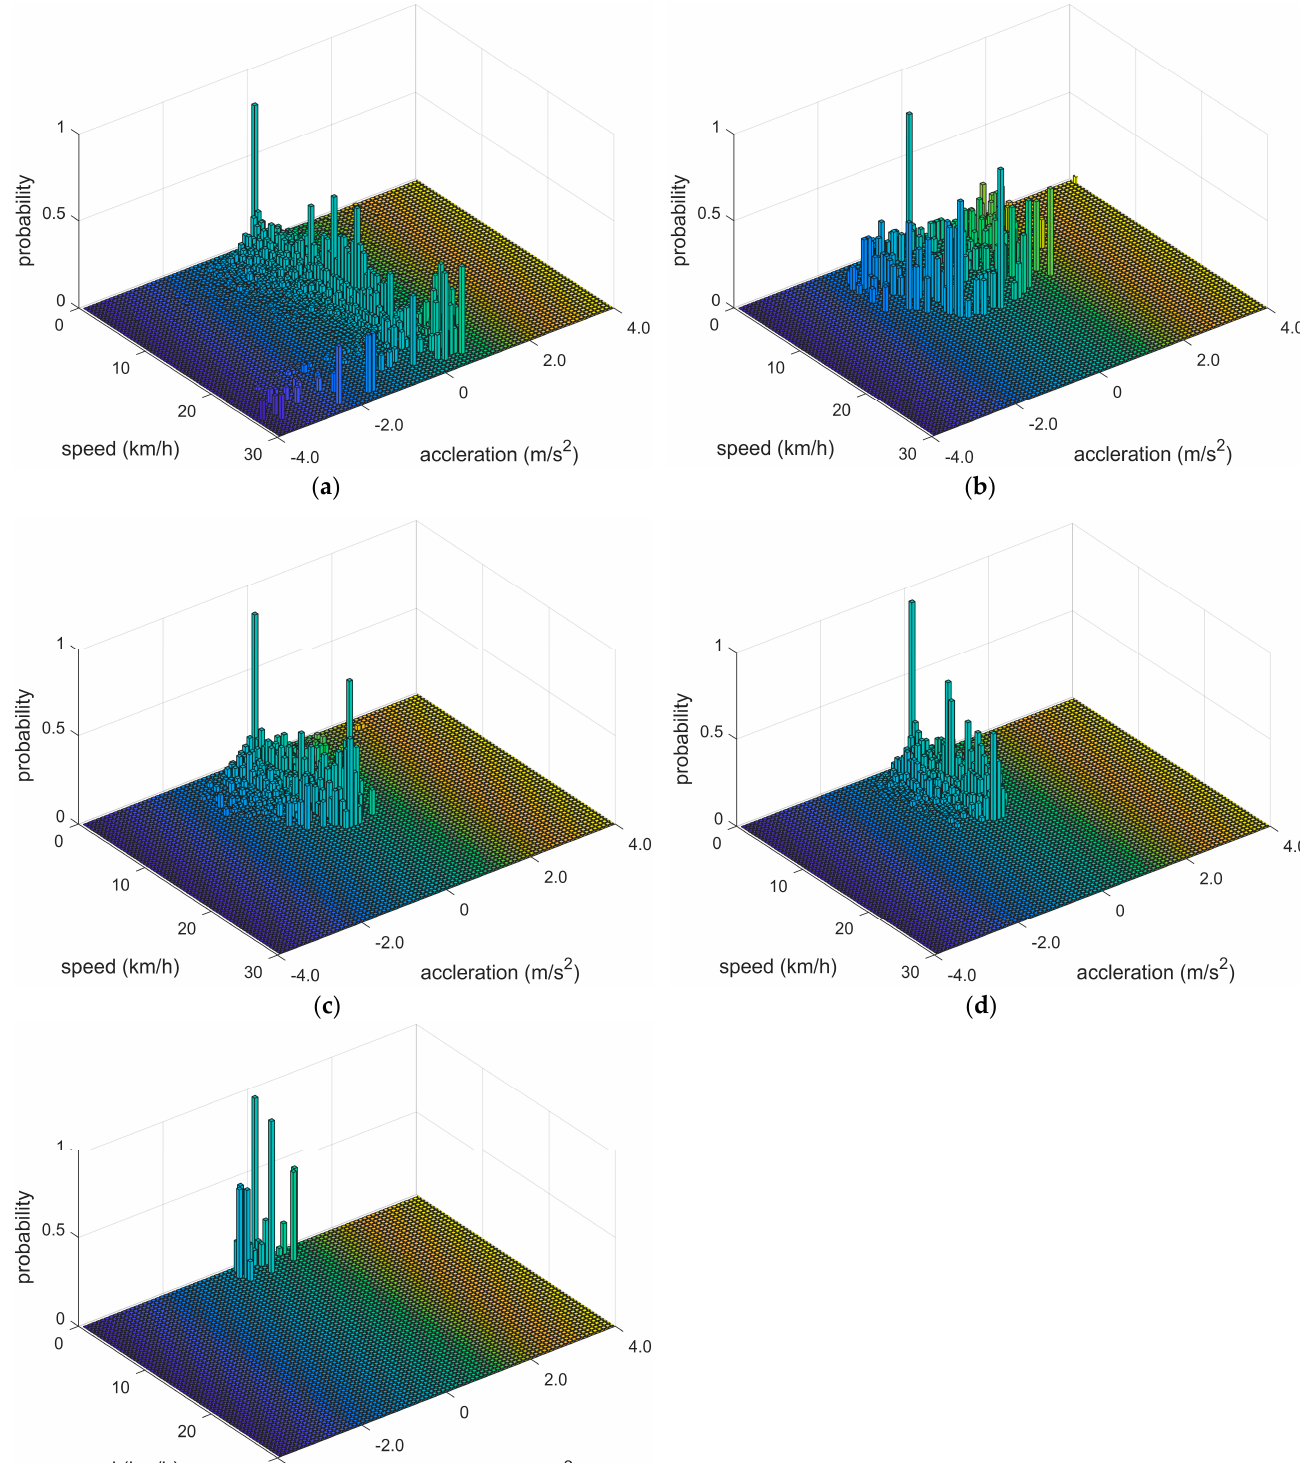
Figure 7. State transition probability of next 5 s ( a – e ).